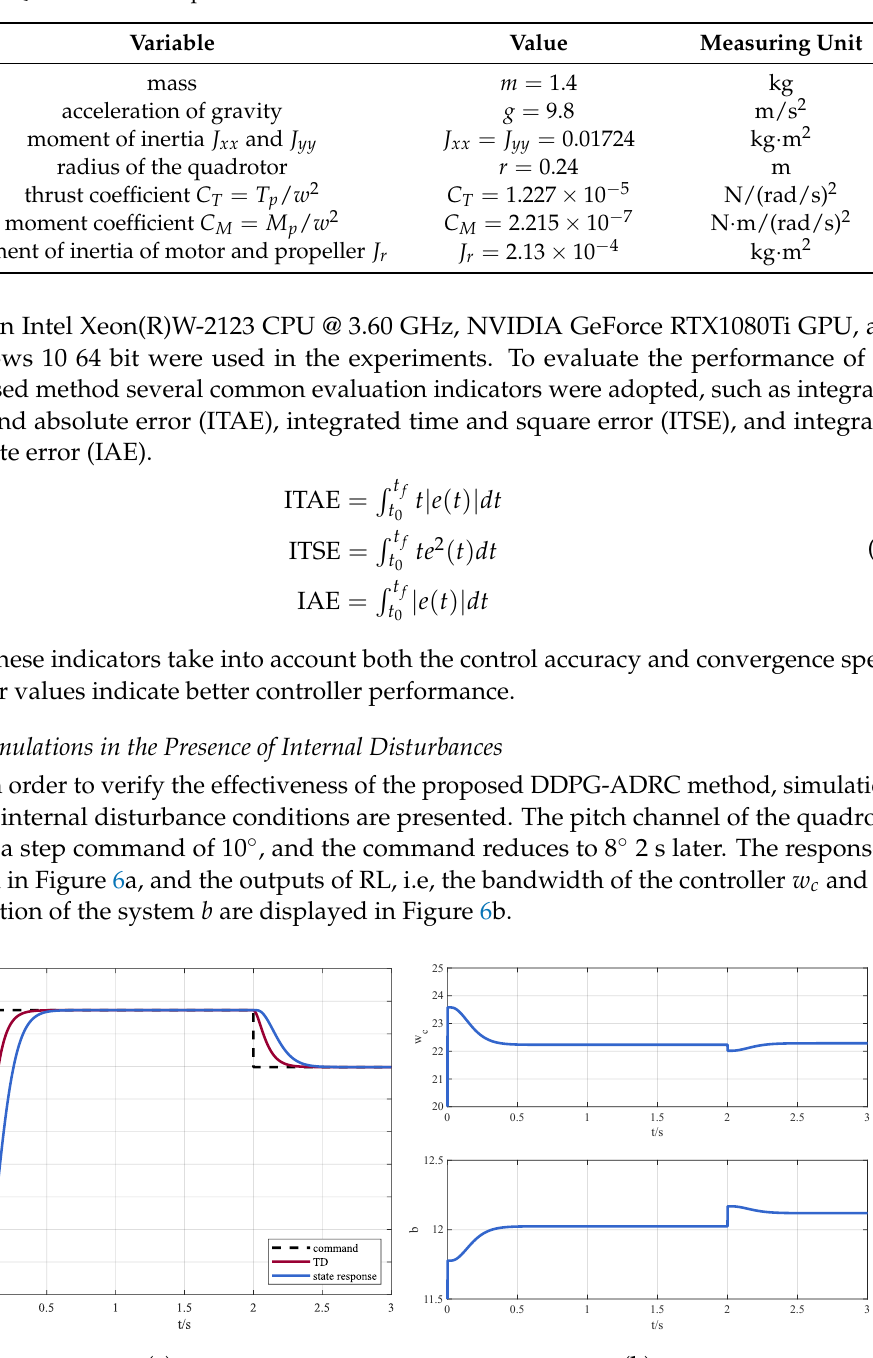
Table 1. Quadrotor model parameters.